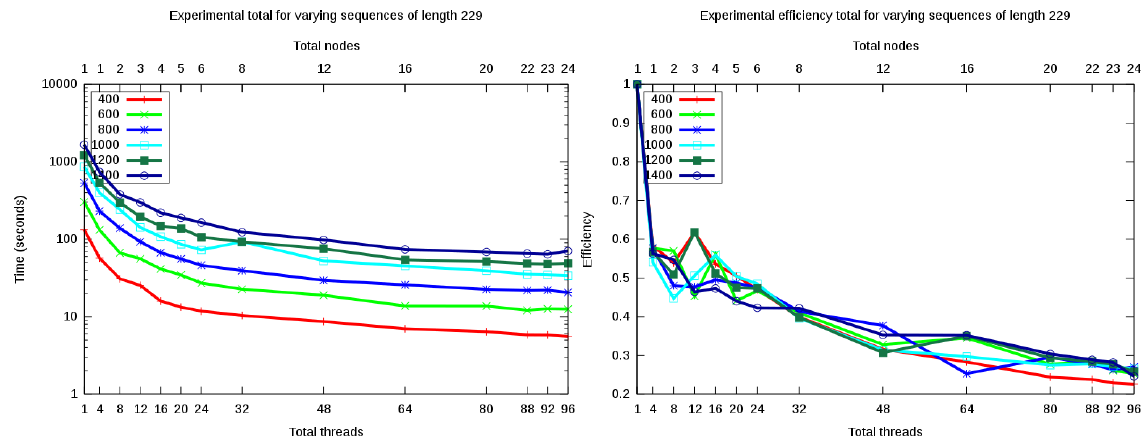
Figure 9: Total pairwise time and Efficiency varying the number of